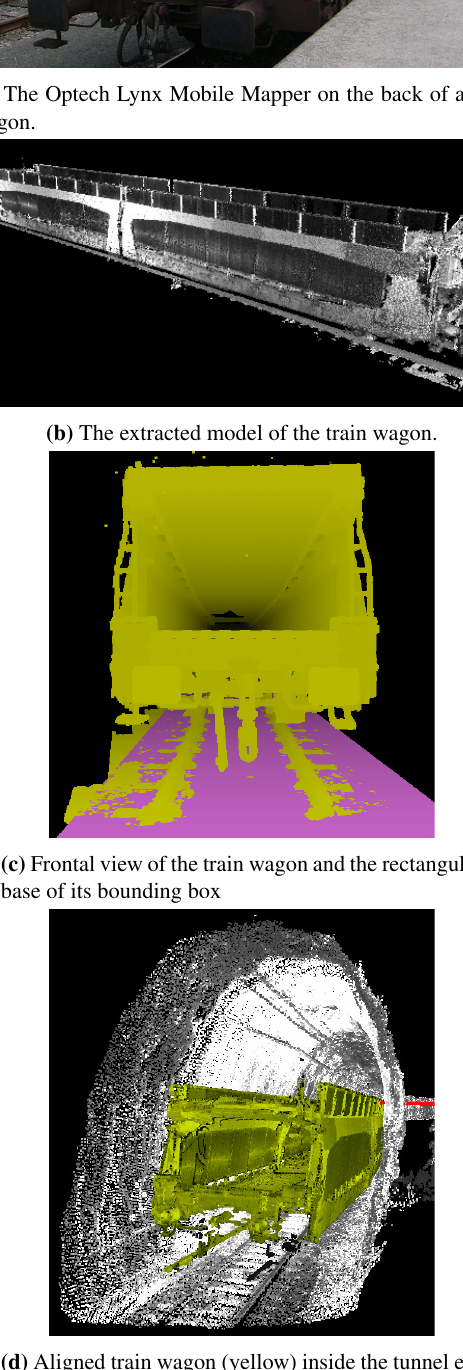
Figure 4: The scanning equipment and the scanned